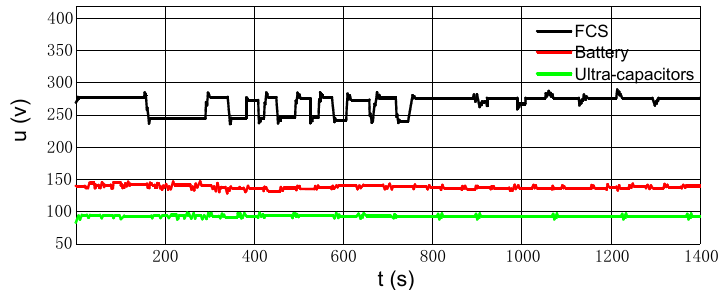
Figure 17. Vehicle speed under the UDDS.